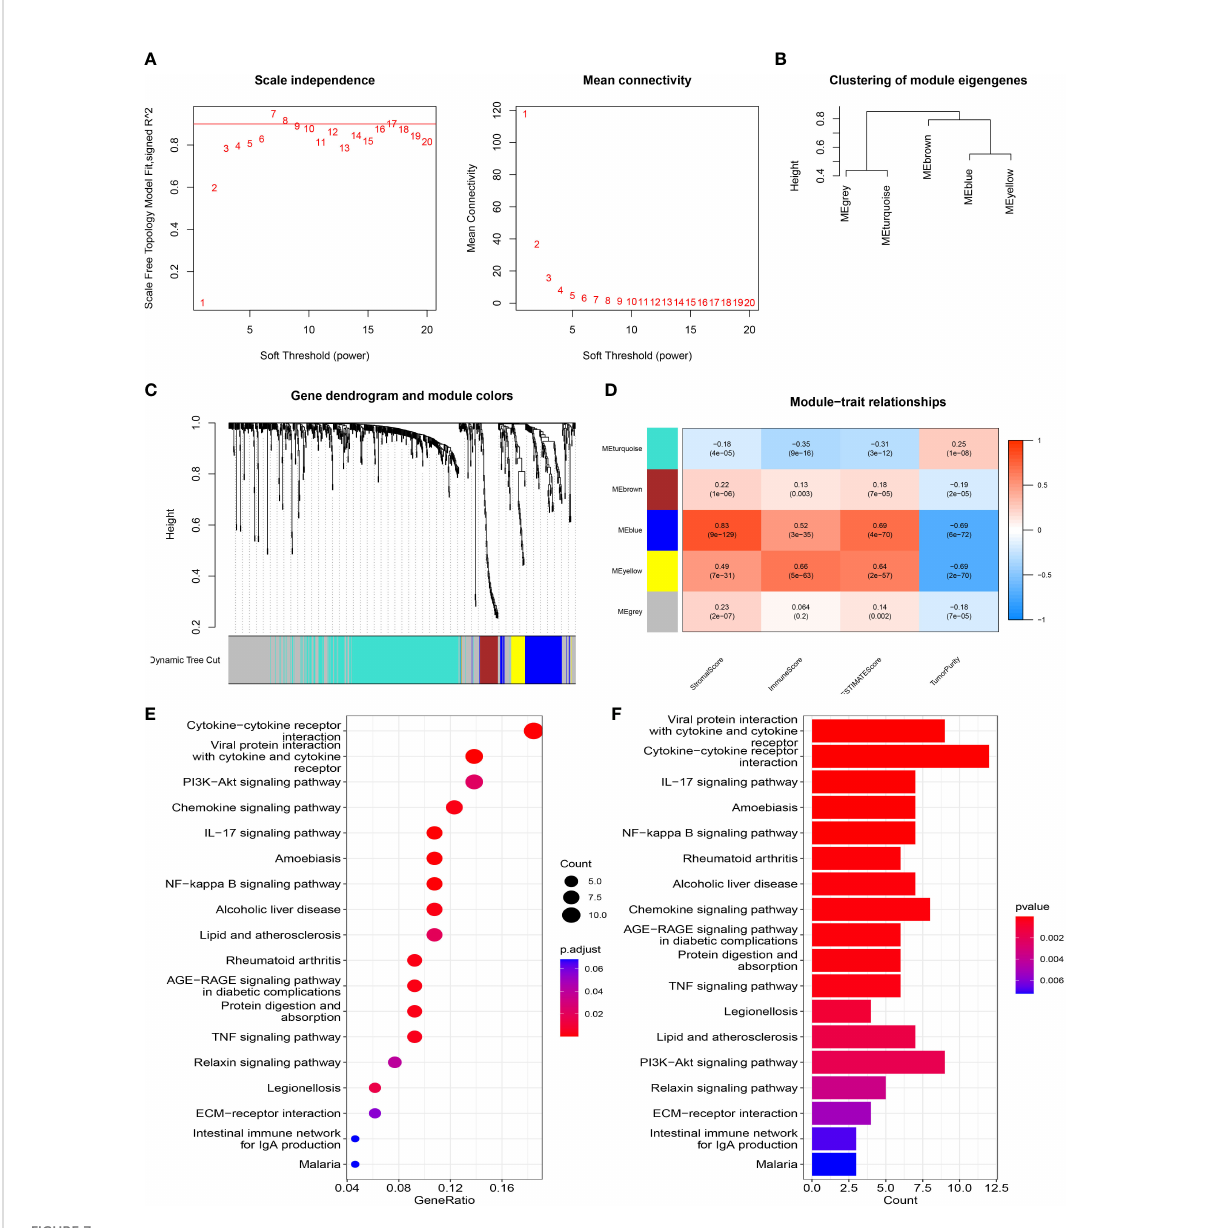
FIGURE 7 WGCNA network module mining. (A) We determined the best soft threshold by network topology analysis. (B) Hierarchical clustering analysis of WGCNA modules. (C) Gene dendrogram and nodule color of WGCNA. (D) The correlation between modules and immune microenvironment scores. (E, F) KEGG